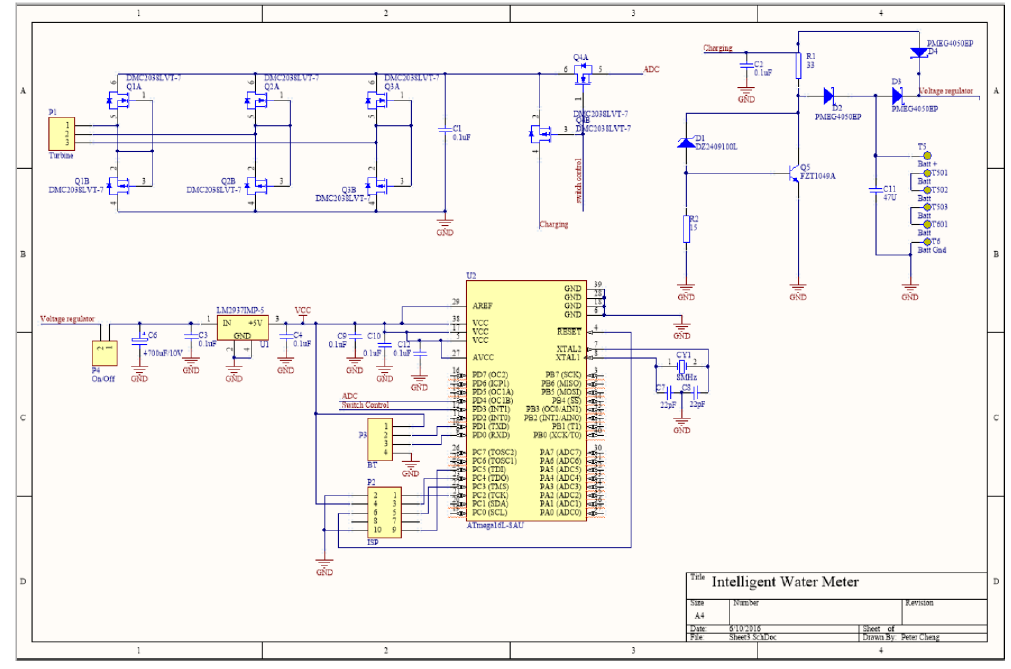
Figure 8. Printed circuit board